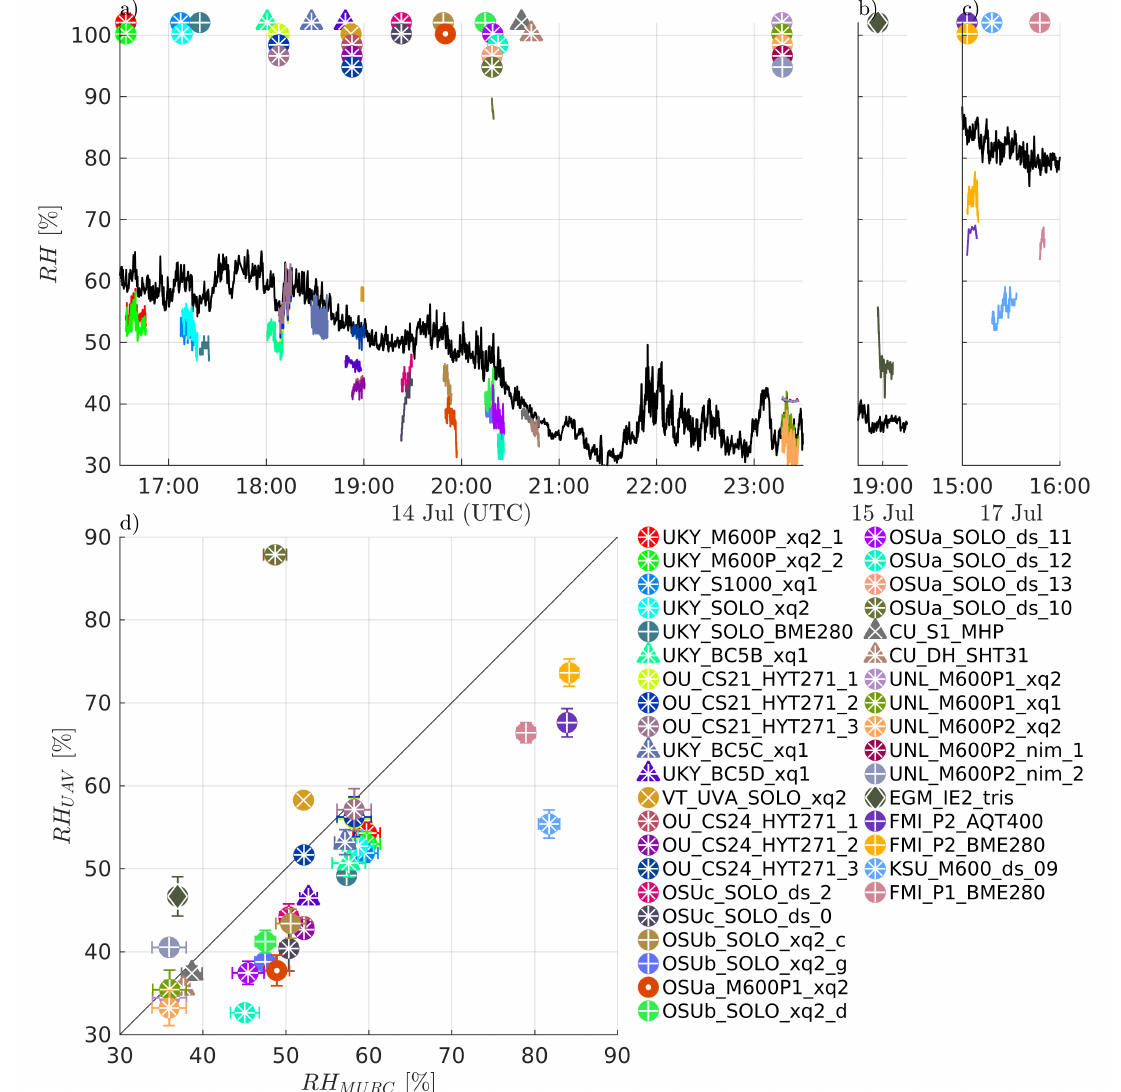
Figure 5. Time series of relative humidity measurements from July 14 ( a ), 15 ( b ), and 17 ( c ) and comparison of mean values to MURC reference measurements ( d ). The colors and markers follow the same scheme as in Figure